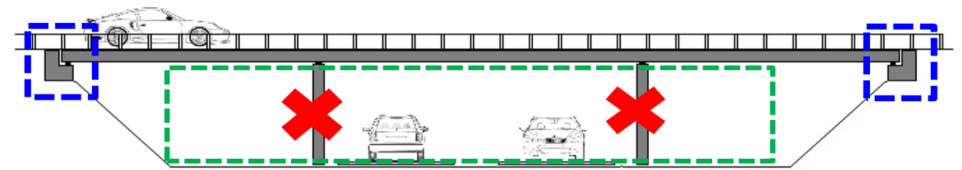
Figure 4. Requirements for an innovative, new bridge replacement concept for existing in-situ cast multi-span concrete plate bridges: no piers (red crosses), maintain profile (green box), no groundwork (green and blue boxes), and reuse of foundation (blue